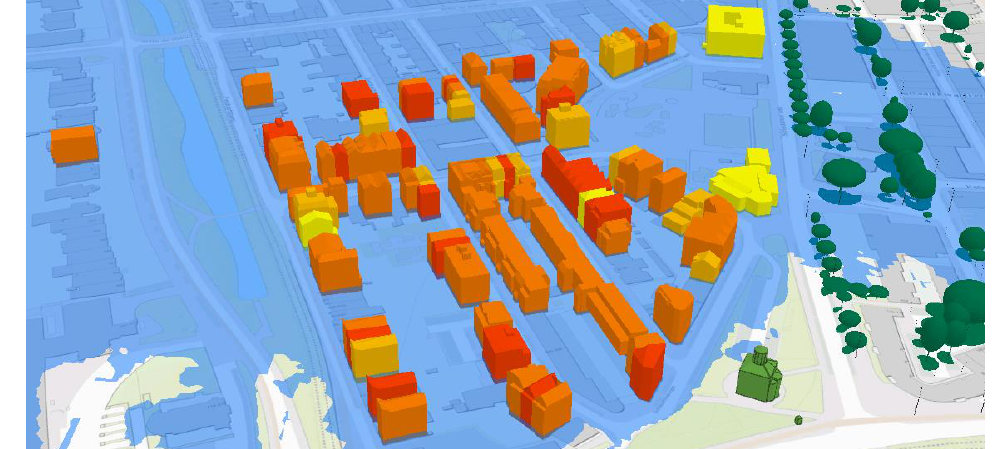
Figure 8. 3D building visualization based on the number of trapped people inside the